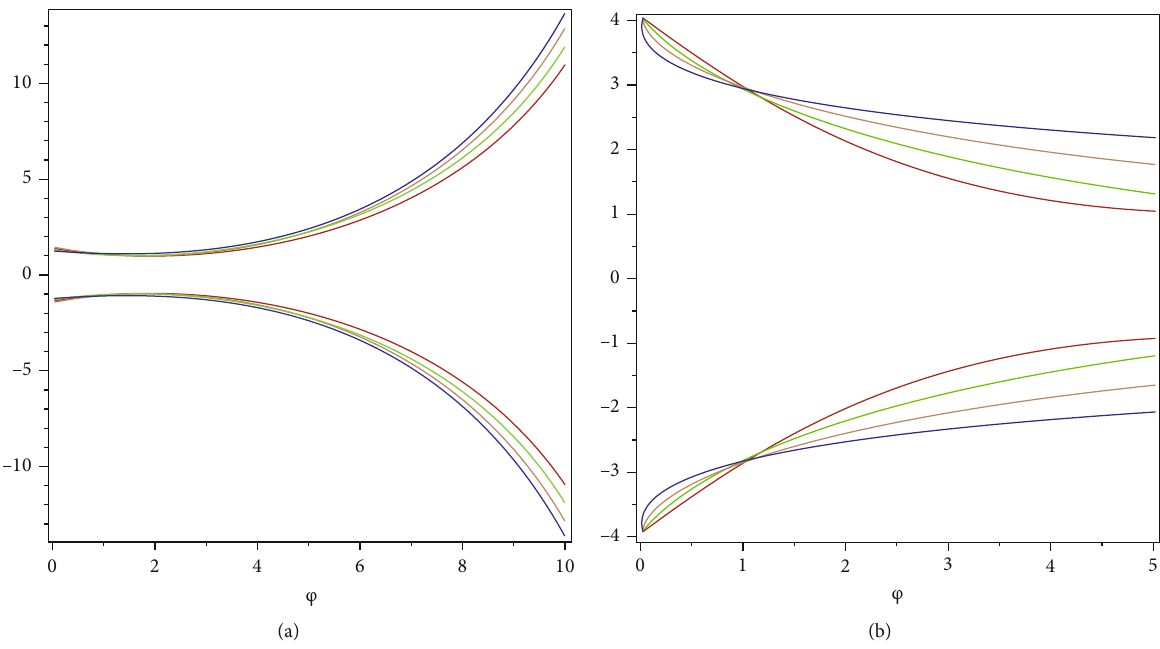
Figure 9: (a) The two-dimensional fuzzy lower and upper branch graph of the di ff erent fractional-order of ϱ with respect to φ and (b) with respect to I